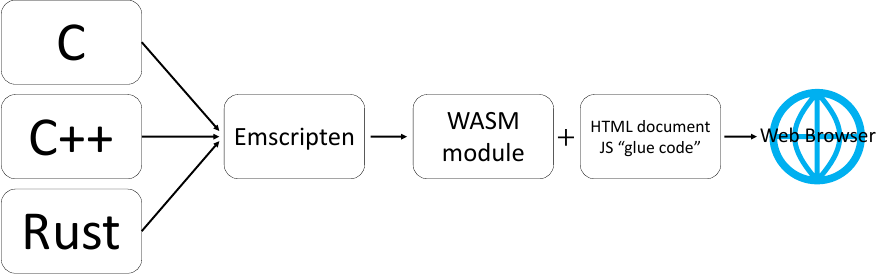
Figure 3. Web Assembly conversion process